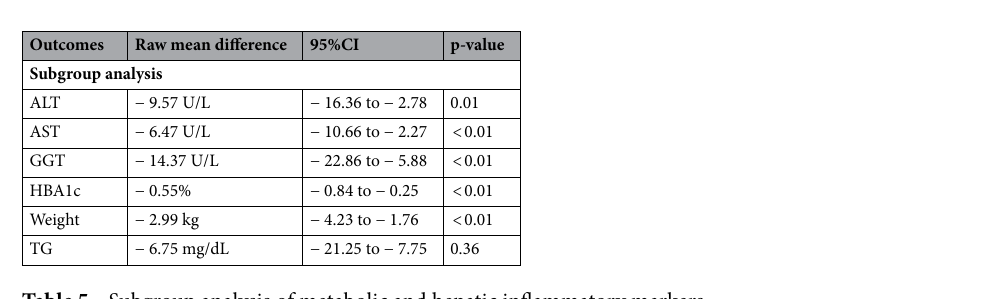
Table 5. Subgroup analysis of metabolic and hepatic inflammatory